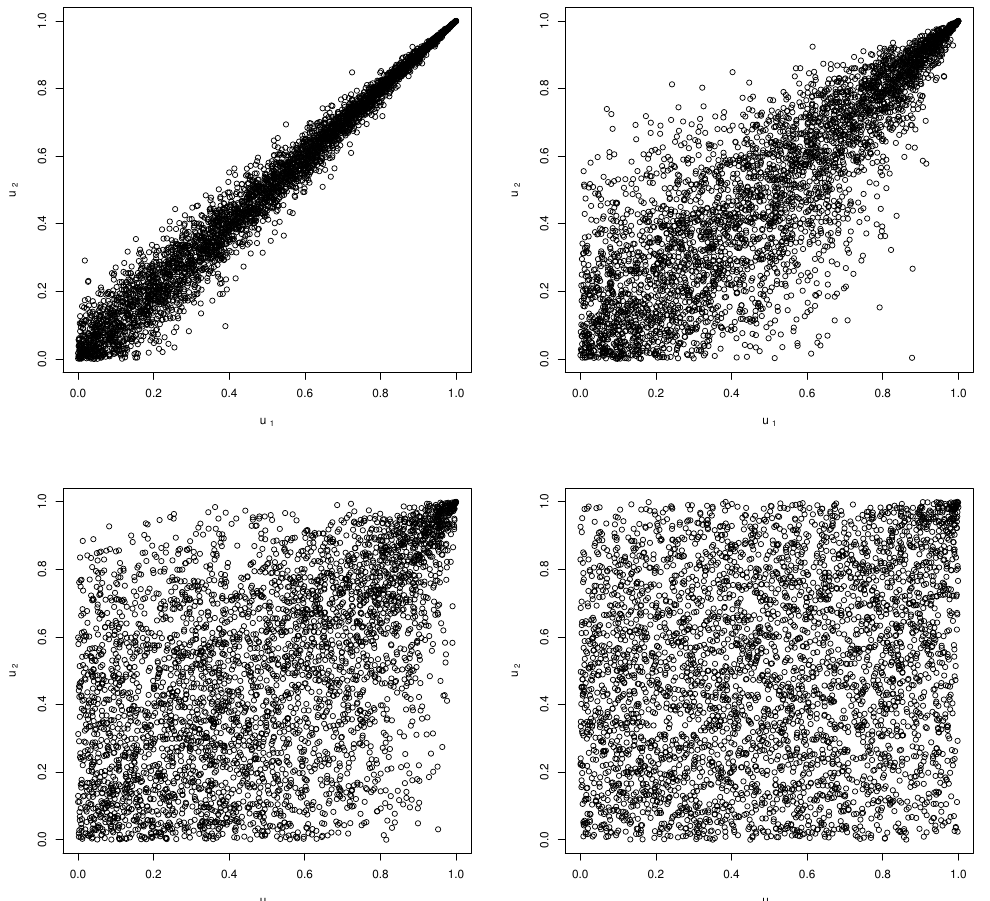
Figure 1. Scatter plots of the MMG copula (4000 simulation points) for varying values of the γ parameter: γ = 0.05 ( top left ), γ = 0.2 ( top right ), γ = 0.5 ( bottom left ), γ = 0.8 ( bottom right